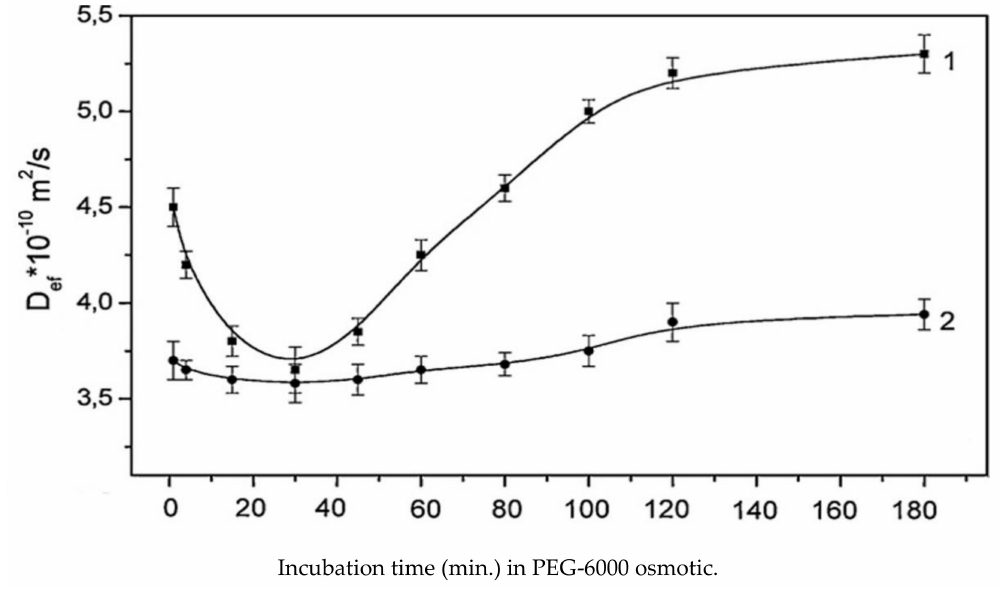
Figure 14. Def dependencies on time (in minutes) of PEG-6000 osmotic action for roots in normal conditions (1) and (2) roots pre-treated with aquaporin blocker (15 min, 0.1 Mm HgCl 2 at t d =100 mc),